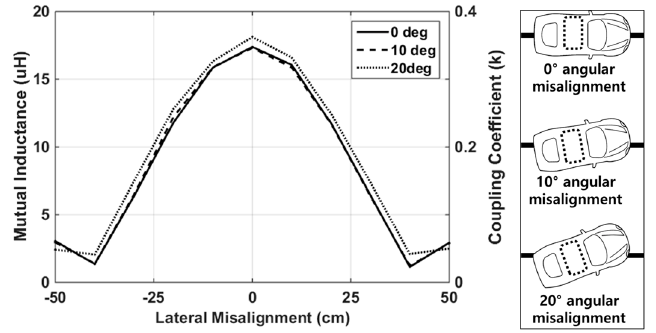
Figure 5. 3-D EM simulation result showing the change in the mutual inductance and coupling coefficient due to lateral misalignment and angular misalignment.